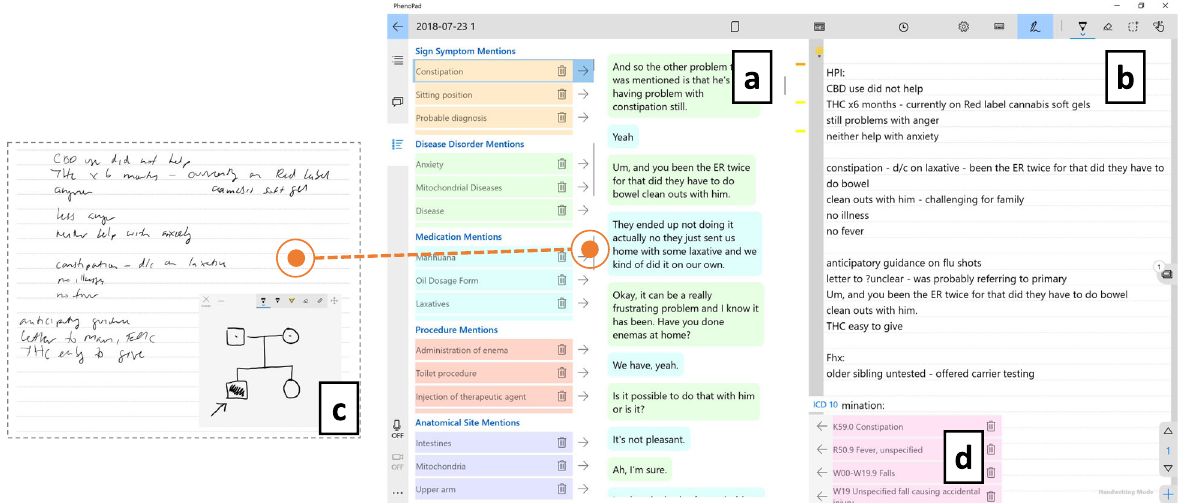
Fig. 4 Note generation interface design. a Speech Transcripts Panel is for presenting the transcripts of the conversations (right) and medical information recognized from the transcripts (left). When clicking on a medical term, the positions where it appears are highlighted as yellow bars (or an orange bar if it is the one currently being shown). b Note Writing Panel is a regular text box for note writing and editing. Clinicians can add information from ( a ) into ( b ) by dragging and dropping the text in ( a ) into the desired position in ( b ). c Raw Notes Panel presents the raw notes including handwritings, drawings, photos, and/or videos. Clinicians have the option to switch between ( a ) and ( c ). d ICD 10 List contains a list of ICD 10 codes recognized from the conversation and used for billing purposes.